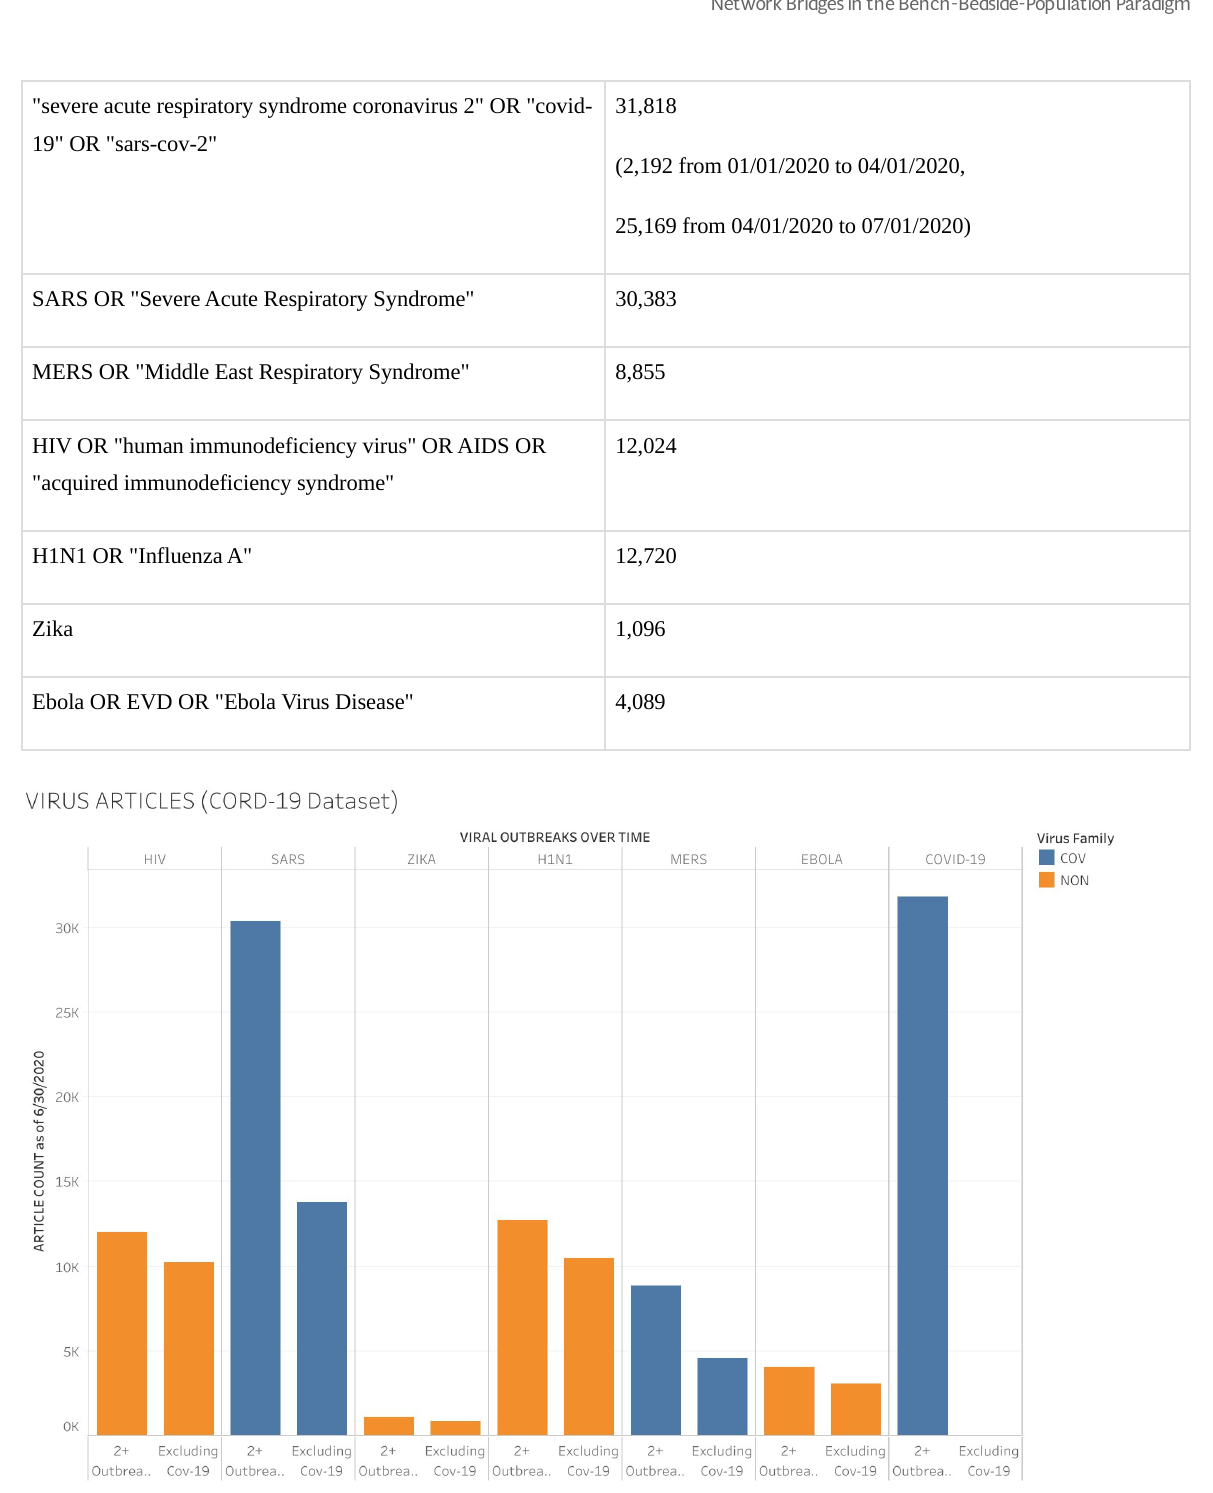
Figure 1. Number of documents in